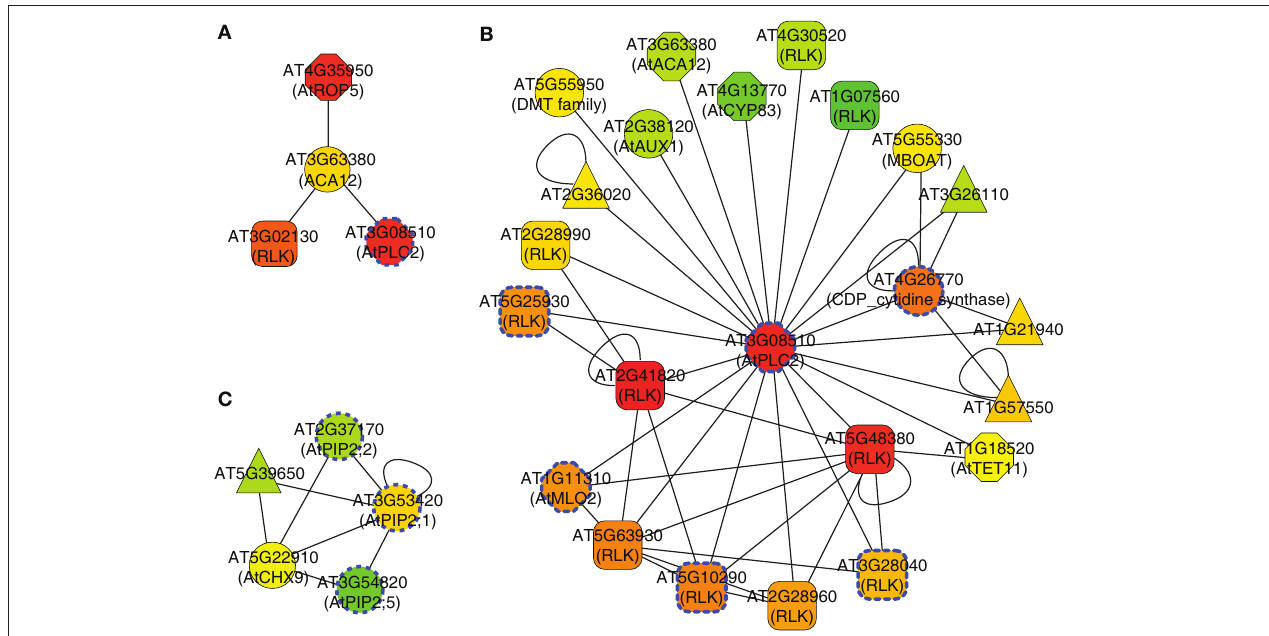
Figure 7 | Sub-network of calcium ATPases, phospholipase C2 and aquaporins. (A) ACA12 sub-network (AT3G63380), (B) PLC2 sub-network (AT3G08510), and (C) aquaporin sub-network. Labeling as in Figure 5 .